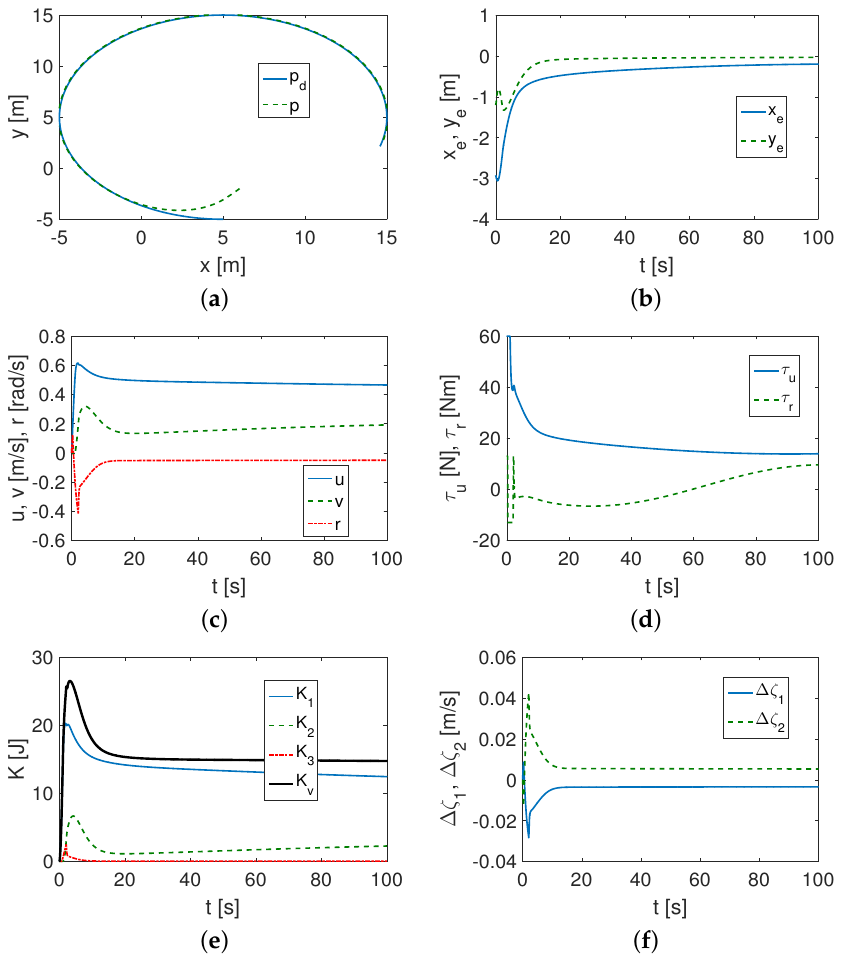
Figure 8. Results for the CETUS II, QV controller and partial circular trajectory: ( a ) desired and realized trajectory; ( b ) position errors; ( c ) velocity errors; ( d ) applied force and torque; ( e ) kinetic energy time history; ( f ) quasi-velocity errors ∆ ζ 1 , ∆ ζ 2 .